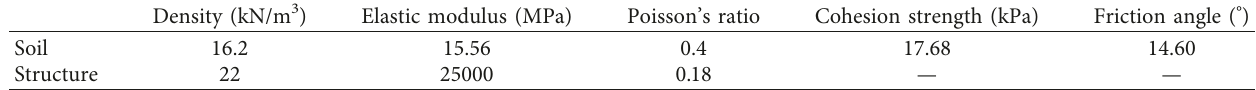
Figure 8: Numerical simulation model of the shaking table test. Table 4: Material parameter of soil and structure.